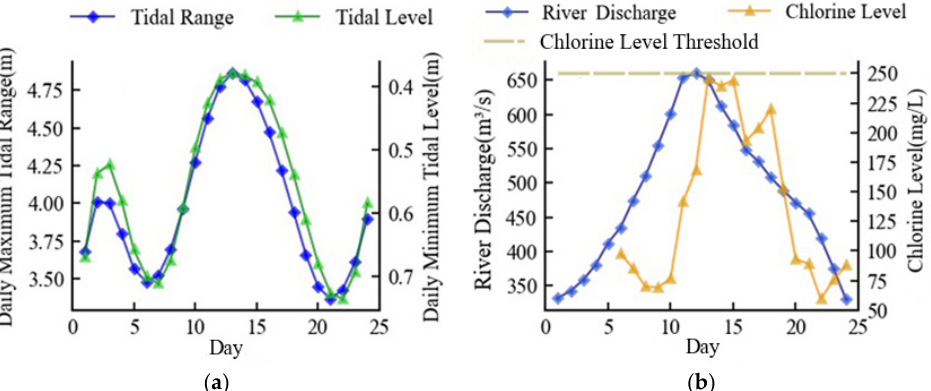
Figure 8. Minimum discharge scheme in the fi rst tide scenario: ( a ) simulation of tide; ( b ) optimized river discharge and simulation of chlorine level.